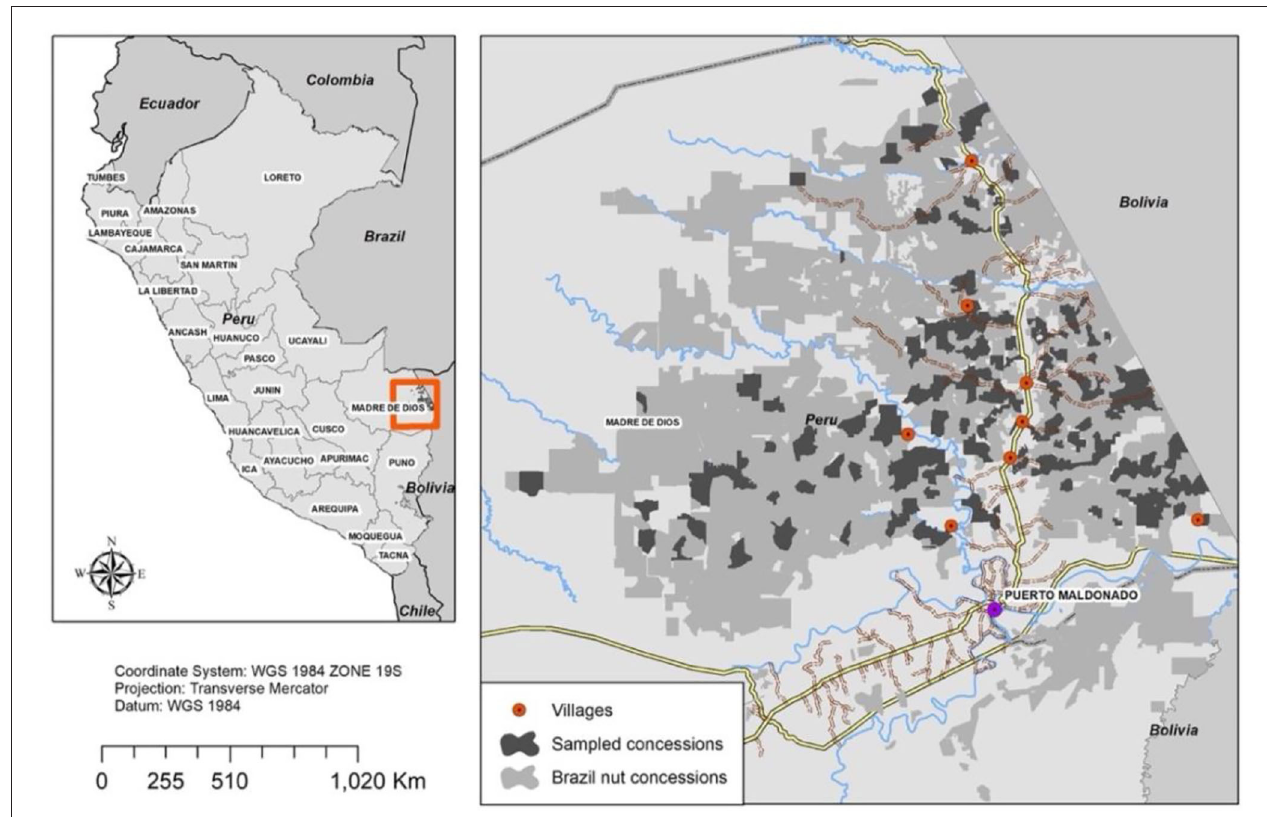
FIGURE 1 | Location of Madre de Dios and Brazil nut